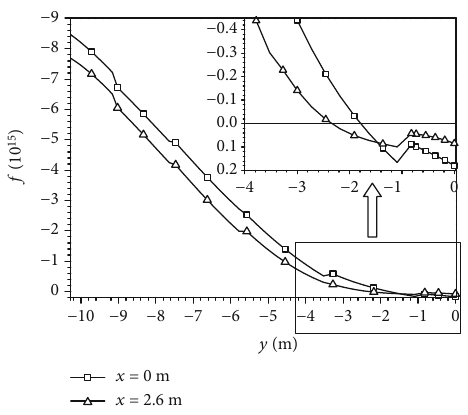
Figure 6: Breaking function curve of the composite beam.